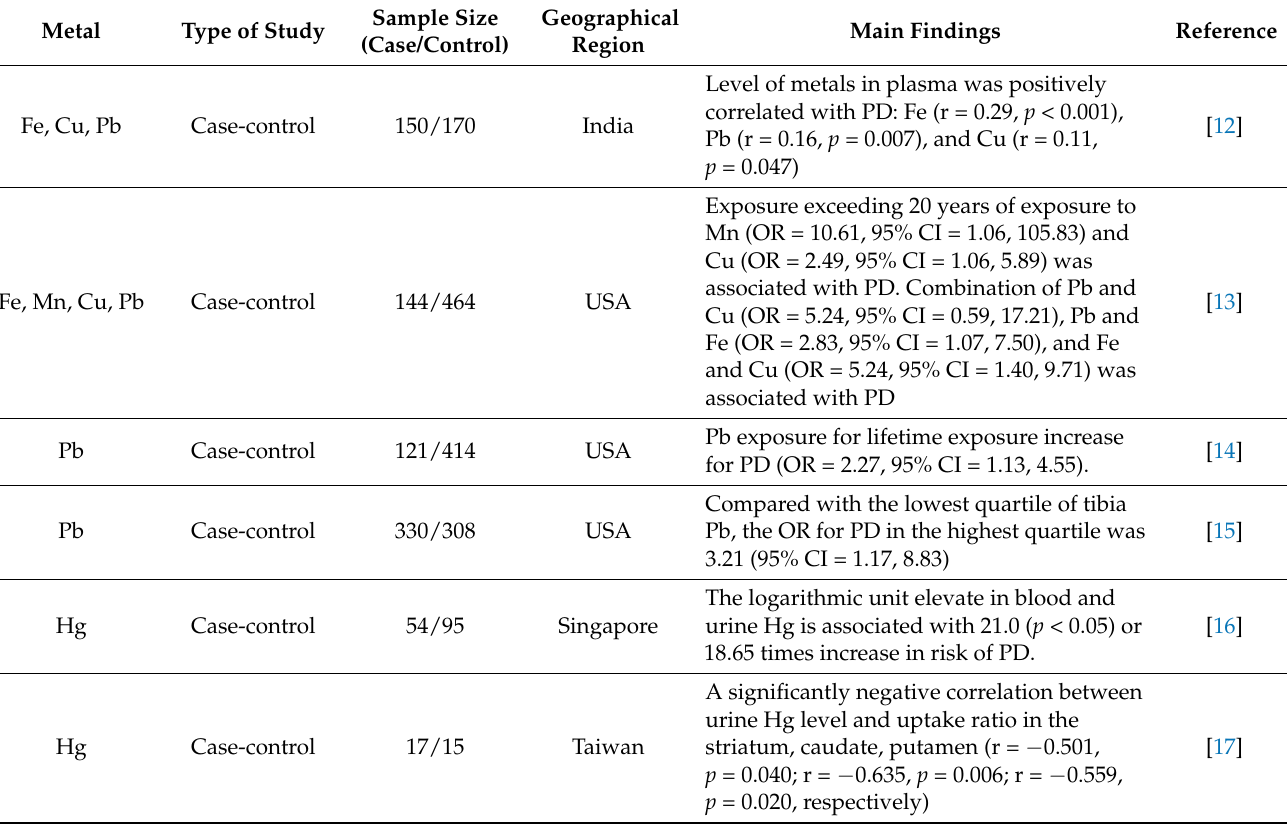
Table 1. The epidemiological studies that associate metal exposure with an increased probability of